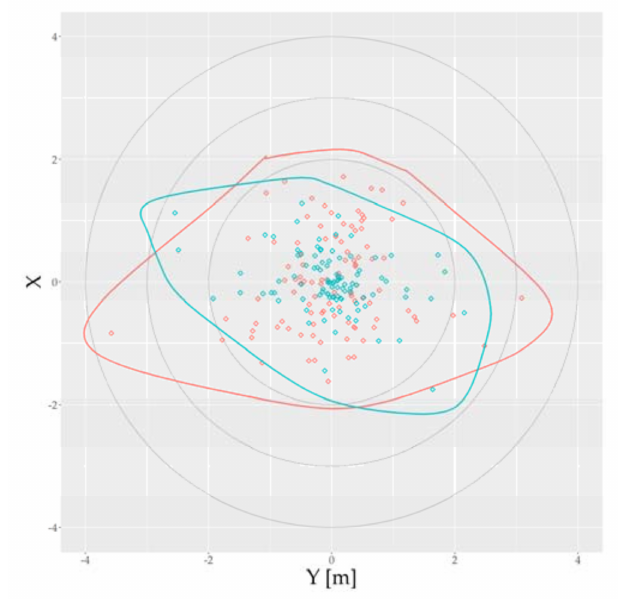
Figure 2. The diversity of precision for the LT700H (red color) and Stonex S900A (green color) receivers is expressed in meters.